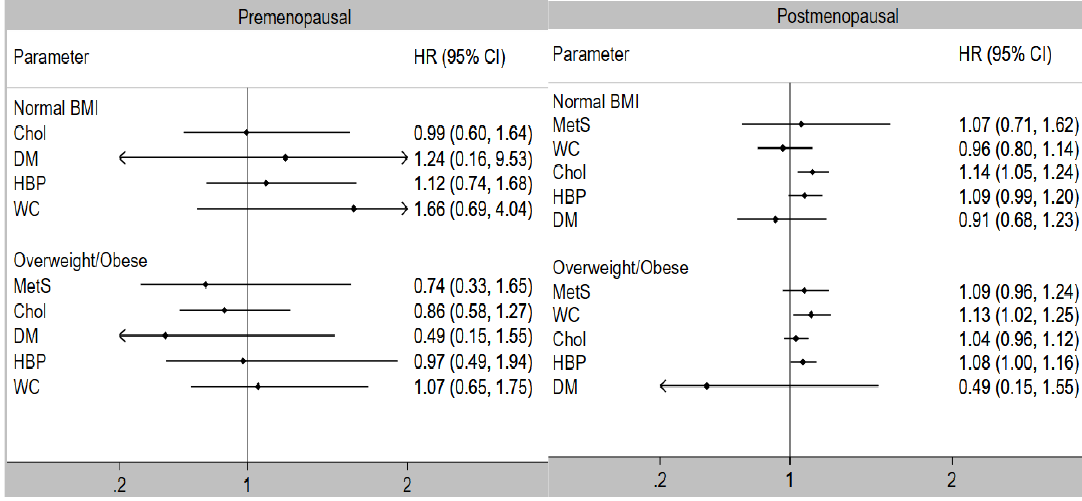
Figure 2. Association of metabolic syndrome (MetS) and its components with the risk of breast cancer by menopausal and obesity status. Abbreviations: BMI, body mass index; Chol, elevated cholesterol; DM, diabetes; HBP, high blood pressure; HR, hazard ratio; WC, high waist circumference. The HR for the association of MetS with breast cancer risk was non-estimable for normal BMI premenopausal women. The models are adjusted for age, race, BMI, region, physical activity, smoking, marital status, family history of breast cancer, ovary status, hysterectomy, and hormonal therapy use.